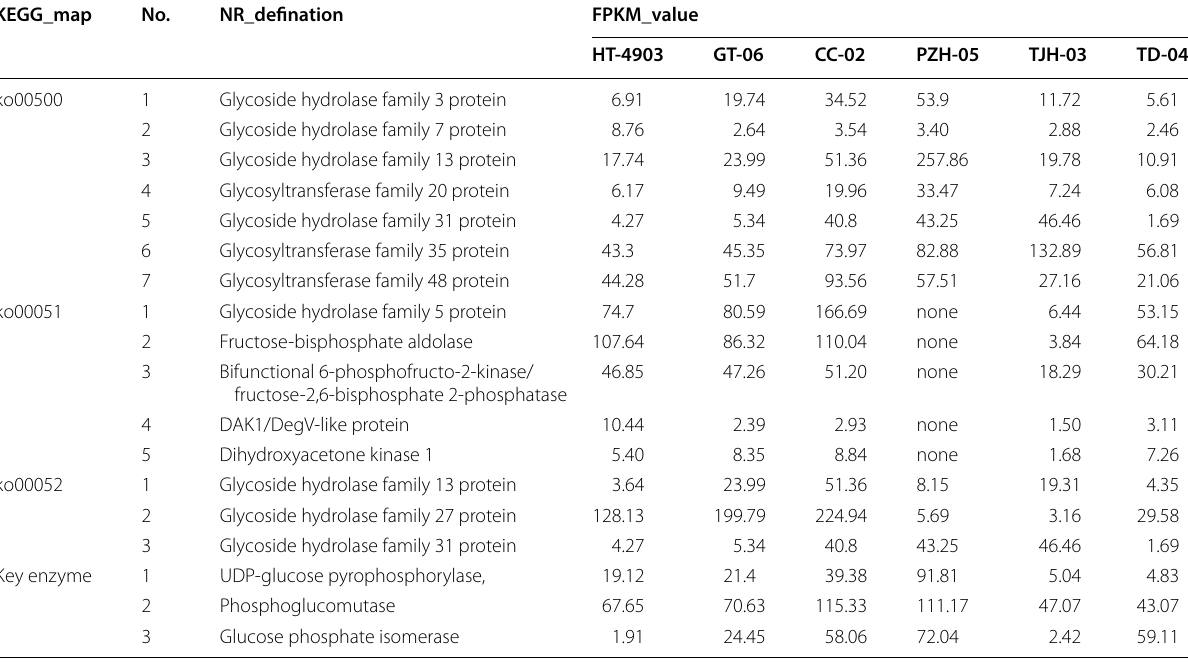
#FPKM value is the mean expression value of three biological replicates. NR_defination means the protein annotated result of six strains transcripts in NR database